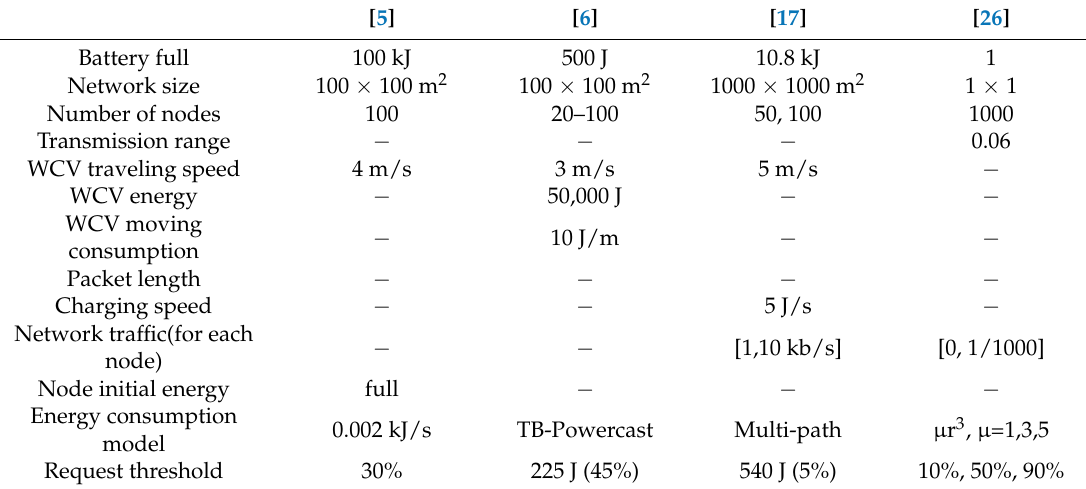
Table 3. Parameter settings used in other